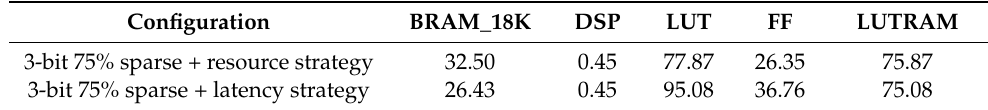
Table 7. Resource consumption (% of available resources of the Zynq Z-7020 FPGA) comparison of the solutions optimized for resources and latency of the